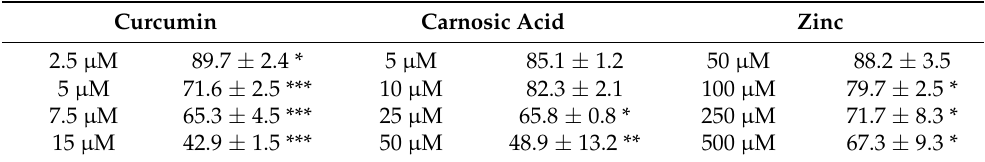
Table 1. Effects of nutraceutical concentrations on relative cell viability. After the initial 6-h exposure, viability relative to untreated control. Data depicted as average ± standard deviation. sterisk (*) p < 0.05, (**) p < 0.01, (***) p < 0.001 for a given concentration and